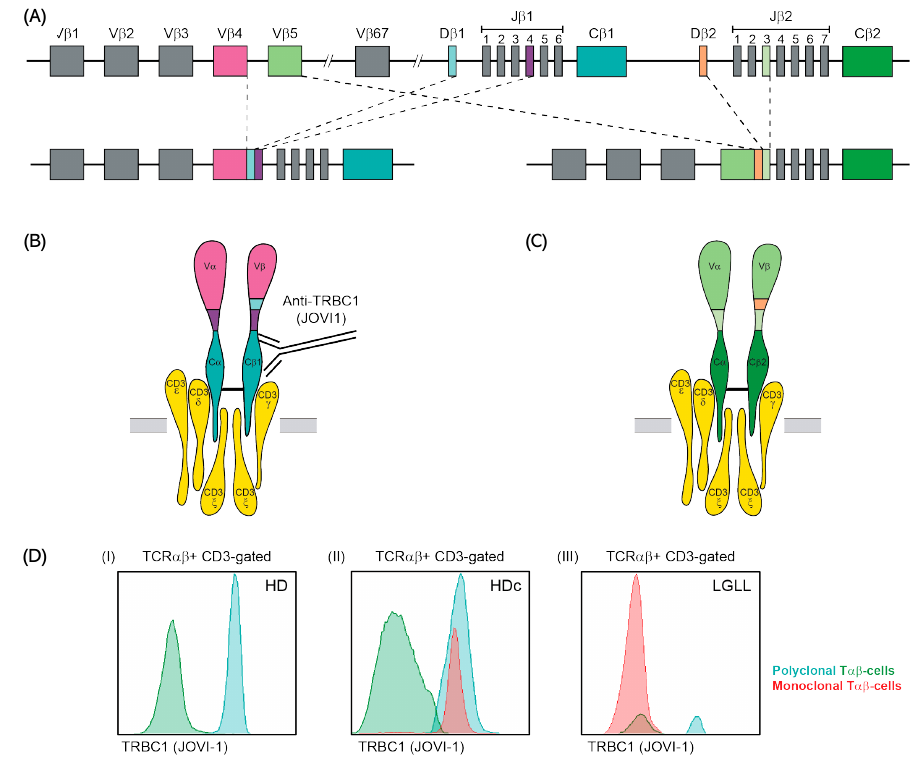
Figure 1. Schematic representation of TRB gene rearrangement and interpretation of the TRBC1 antibody (JOVI-1 clone)-based flow cytometry approach: ( A ) Mutually exclusive TRBC selection during TRB gene rearrangement in the thymus; ( B , C ) Representation of the two resulting TRB complex structures, composed of either the TRBC1 ( B ) or the TRBC2 ( C ) proteins, and specific binding of the anti-TRBC1 antibody to TRBC1 but not to TRBC2; ( D ) Illustrative histograms of TRBC1 staining of blood T αβ -cells from: (I) one representative adult HD, showing the bimodal TRBC1 expression pattern, typical of polyclonal T αβ -cells (TRBC1 + in light blue and TRBC1 − in green); (II) one HDc showing a minor TRBC1 + (clonal) T αβ -cell population (in red), among a majority of polyclonal T αβ -cells; and (III) one LGLL case with a major population of TRBC1 − monoclonal T αβ -cells (in red) with a minor background of polyclonal T αβ -cells. Monoclonal T-cells were